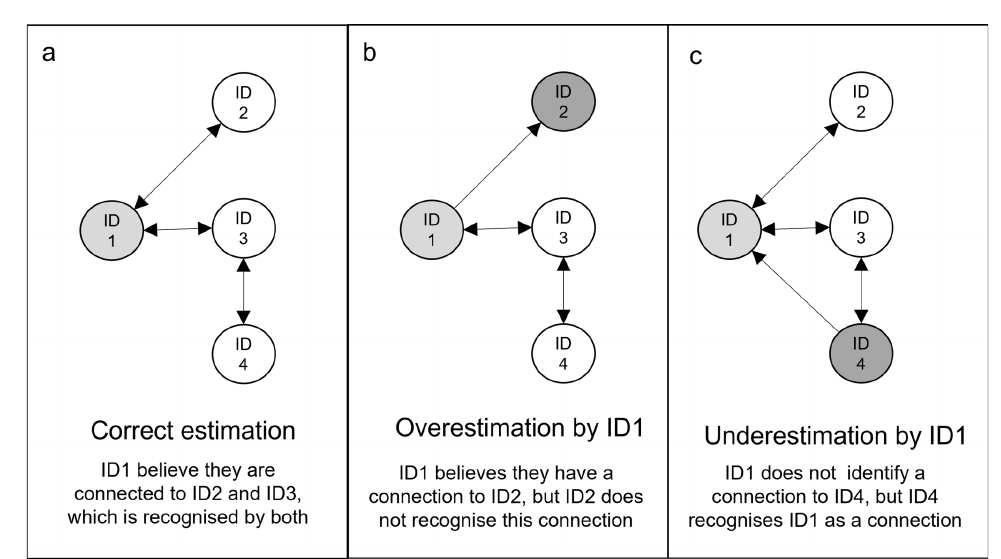
Figure 5 Schematic image of reciprocity in